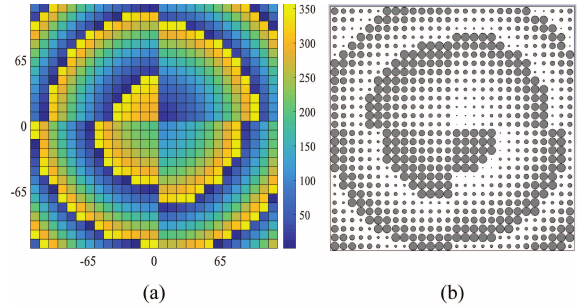
Figure 6: (a) Required phase shift distribution over the de- signed reflectarray aperture. (b) Corresponding dielectric unit cells